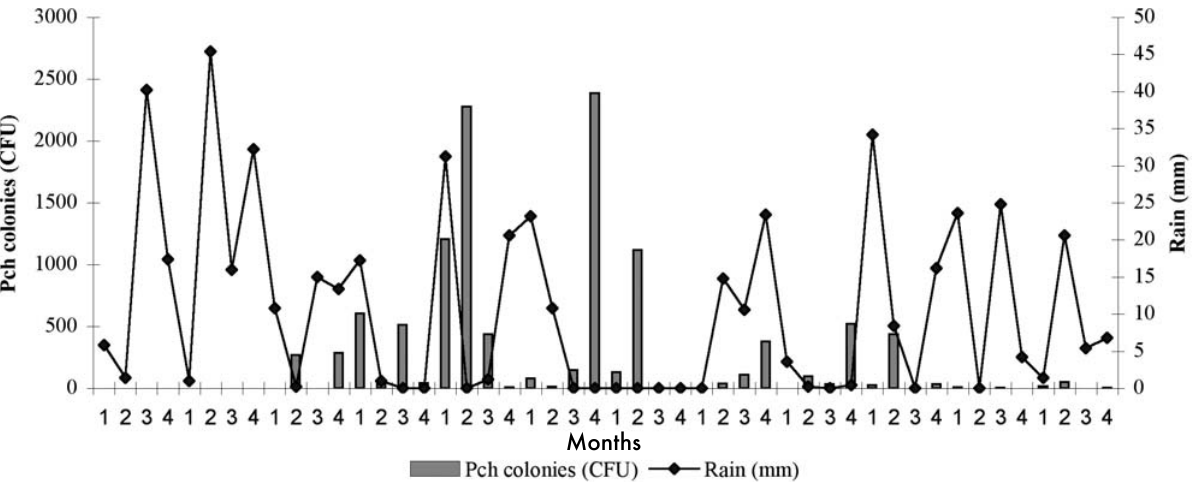
Fig. 7. (a) Number of spores of Phaeomoniella chlamydospora trapped per week and rainfall from January to December 2007.